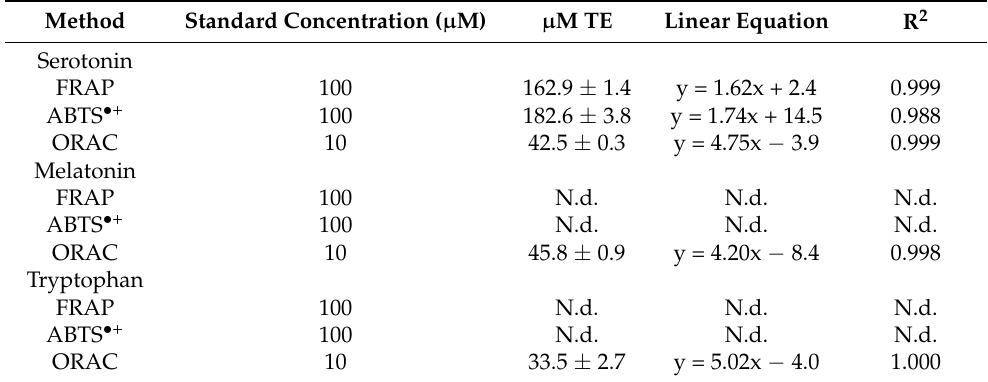
Table 3. Antioxidant capacity of the pure compounds tryptophan, serotonin, and melatonin expressed as µ M Trolox equivalent